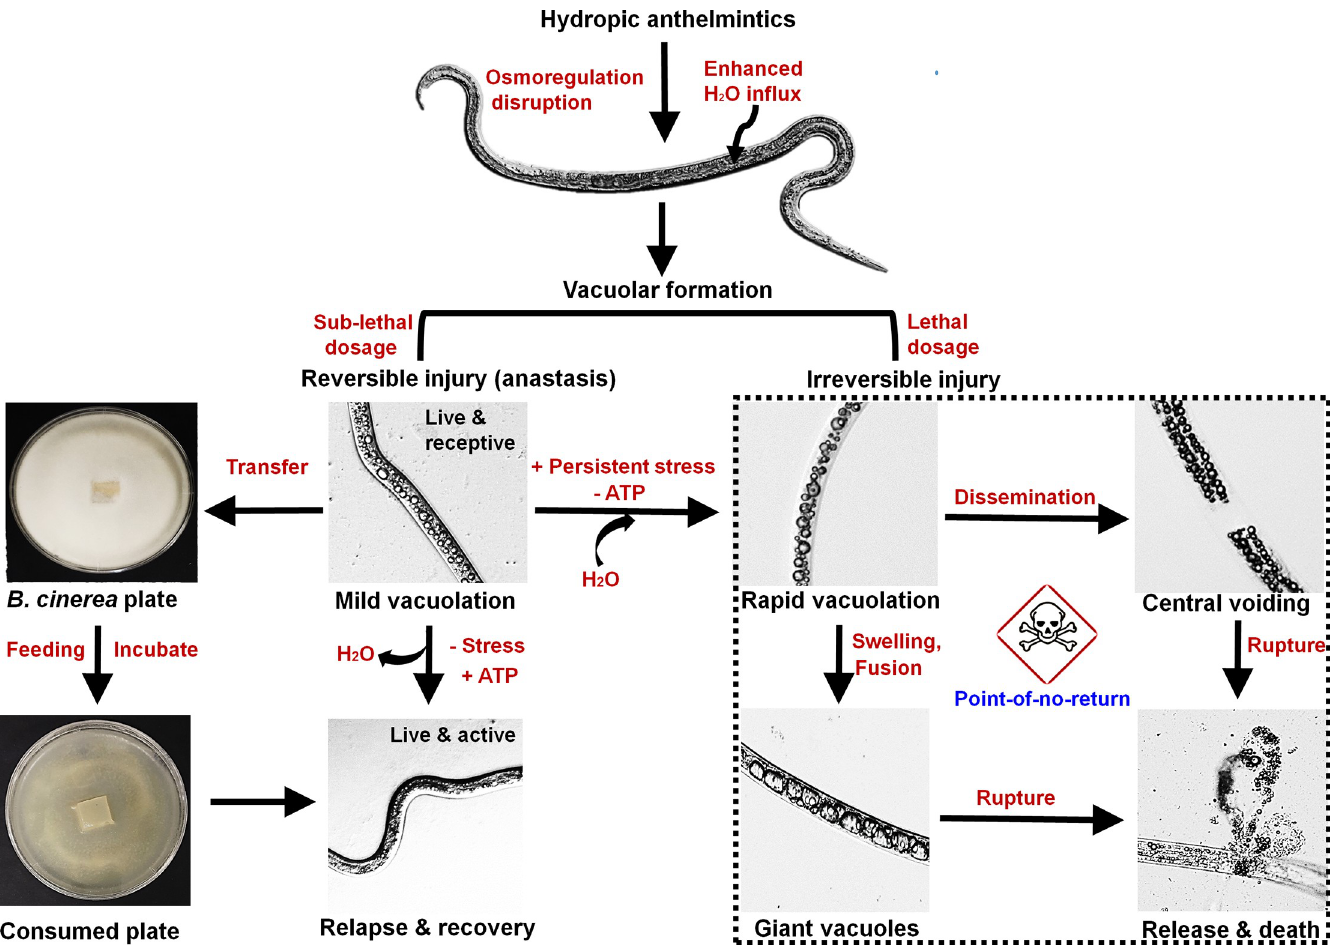
Fig 2. Sequence of vacuolar cell death in parasitic nematodes. Hydropic anthelmintics, such as 5-iodoindole, disrupt osmoregulation causing rapid water influx into nematodes. This leads to the formation of multiple vacuoles. Depending on the severity of the injury or chemical dosages, injury due to vacuolization can be classified as reversible (where the nematodes can be revived back to life) or irreversible (where the nematodes pass the point of no return, causing them to die). ATP, adenosine triphosphate. The phenotypes were re-constructed by adopting images and concepts from our previous publications [12, 14].